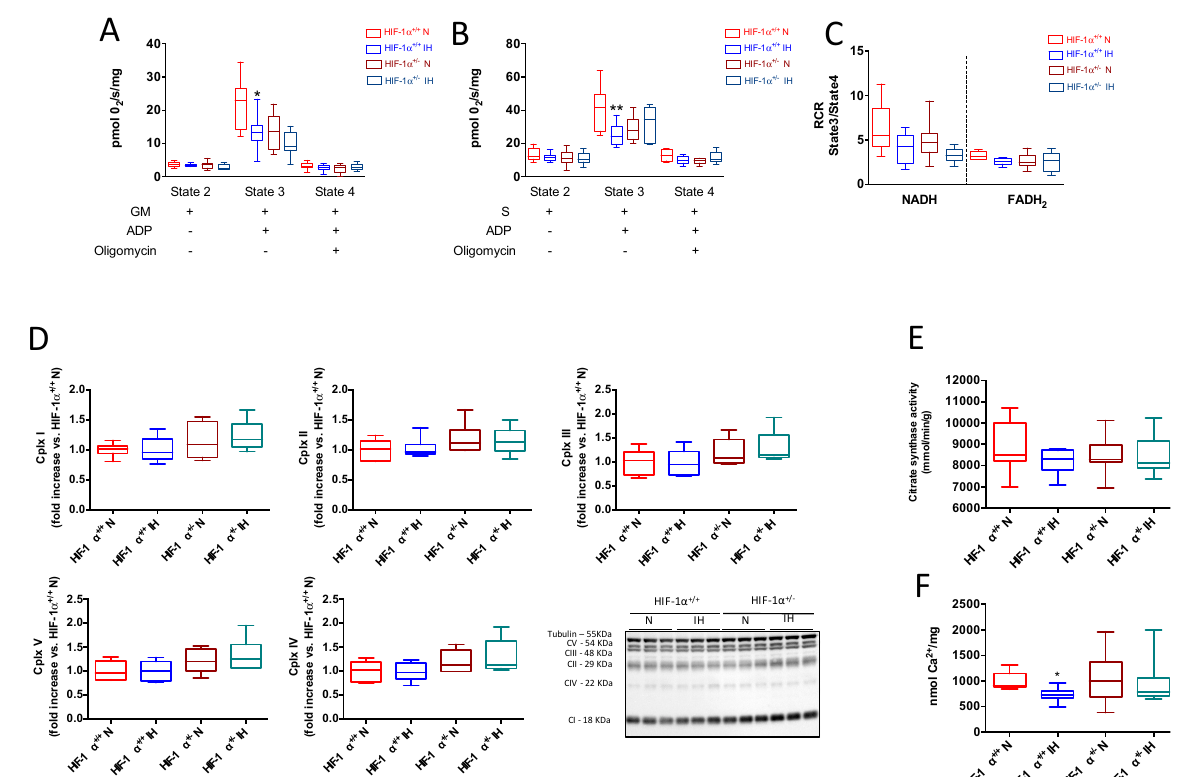
Figure 6. IH-induced mitochondrial respiration alteration is mediated by HIF-1. Mitochondrial oxygen (O2) consumption measured on isolated mitochondria from HIF-1 α +/+ and HIF-1 α +/ − mice submitted to chronic intermittent hypoxia (IH), following sequential addition of substrate (state 2), ADP (state 3, maximal respiration) and oligomycin (state 4). Quantification of O2 consumption for NADH-linked mitochondrial respiration (complex I-glutamate-malate GM) ( A ), and for FADH2-linked mitochondrial respiration (complex II-succinate in presence of complex I inhibition by rotenone) ( B ). Respiratory control ratio (RCR) calculated as the ratio of O2 consumption in state 3 relative to state 4 for NADH and FADH2-linked mitochondrial respiration ( C ), n = 7–10. Quantification of each respiratory chain complex and representative image ( D ), n = 6. Citrate synthase activity ( E ), n = 7–10. Calcium retention capacity expressed in nmol Ca 2+ per mg of mitochondrial protein content, on isolated mitochondria in presence of cyclosporin A (CsA, 1 μ M) ( F ). Data are expressed in median and min to max values and analyzed using Kruskal–Wallis followed by Dunn’s test; * p < 0.05, ** p < 0.01 vs. N.